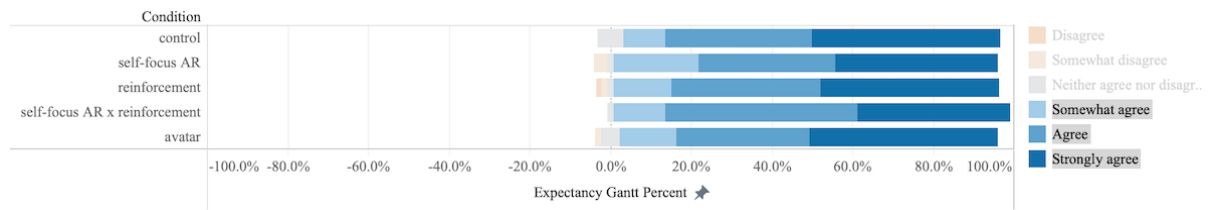
Figure 10. Responses for outcome expectancy. Responses are strongly skewed toward higher levels of agreement for all conditions, indicating a ceiling effect. AR: augmented reality.